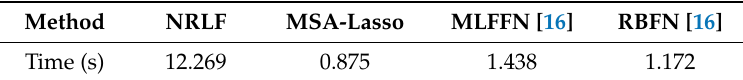
Table 13. Comparison of computation times of the 118-bus system. MLFFN: multi-layer feed forward network; RBFN: radial basis function